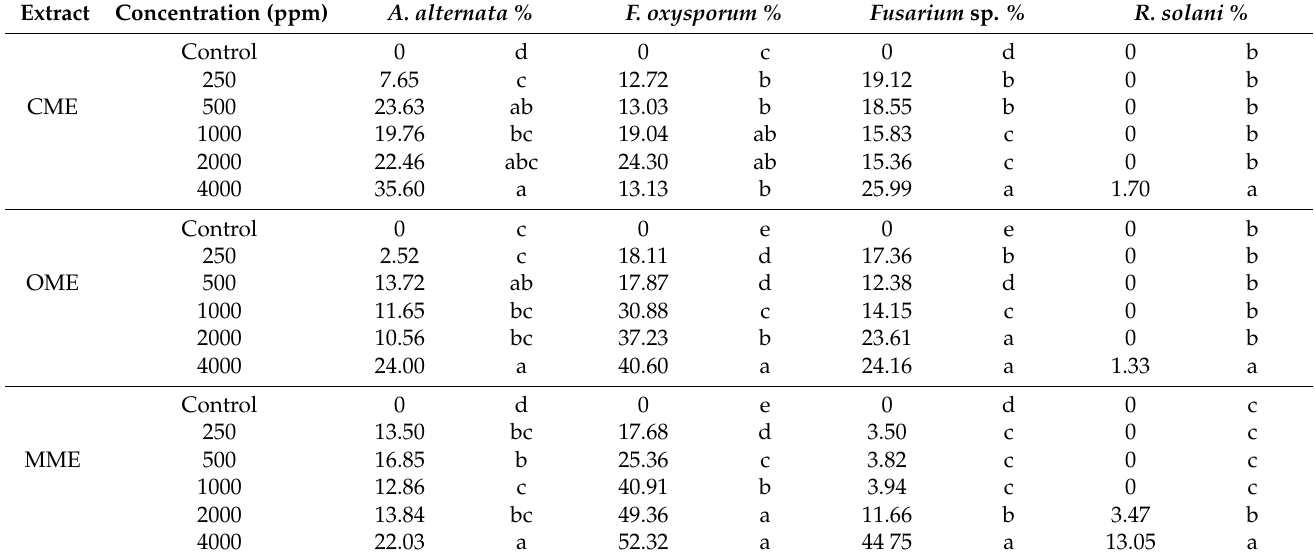
Table 3. Percent inhibition of mycelial growth of tomato phytopathogenic fungi when grown on a medium poisoned by polyphenols obtained from the mistletoe extracts of different